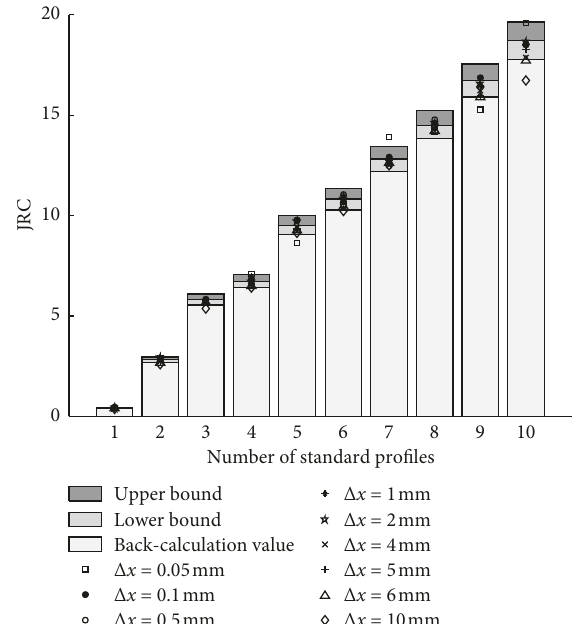
Figure 8: Comparison of the JRCs at different Δ x values. Note: JRC